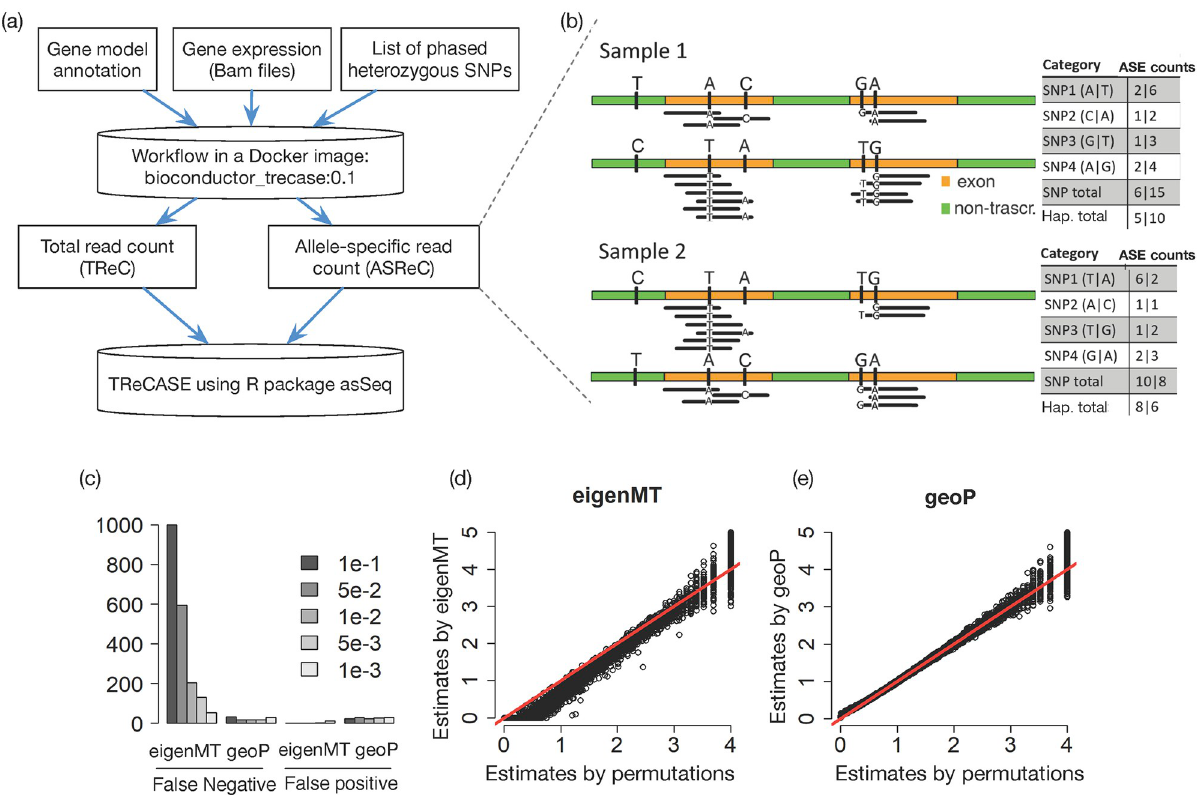
Fig 1. Overview of our pipeline and geoP method. (a) A workflow starting with raw data on the cloud to extract gene expression information, followed by eQTL mapping using TReCASE. (b) Quantification of ASE by counting allele-specific reads. The table on the right side shows the count for each SNP and the summation (SNP total) or the total count on haplotype level (ASE count) and the latter avoids double counting. (c-e) Comparison of permutation p-values estimated by eigenMT or geoP, versus “true” values generated by 10,000 permutations, using the eQTL data of 14,566 genes from the GEUVADIS dataset [13]. (c) The number of false negatives or false positives at each permutation p-value cutoff labeled in the legend. A gene is considered as false negative (positive) at a cutoff α if its permutation p-value estimate is larger (smaller) than α , while the “true” value from 10,000 permutations is equal to or smaller (larger) than α . (d-e) A scatter plot of -log 10 (permutation p-value) estimated by 10,000 permutations (x-axis) versus the estimates by eigenMT or